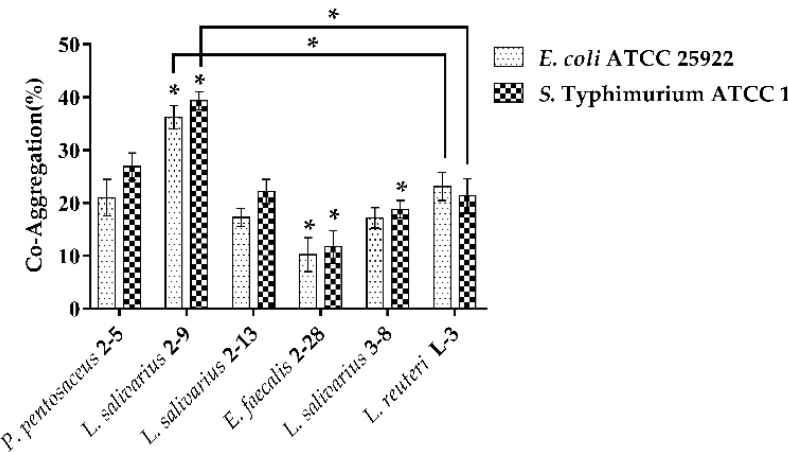
Figure 3. Co-aggregation of strains with pathogenic bacteria was determined after 4 h of incubation at 37 °C. The results represent the mean ± SD of three independent experiments. The significant difference was indicated by asterisks compared to P. pentosaceus 2–5: * p <0.05.